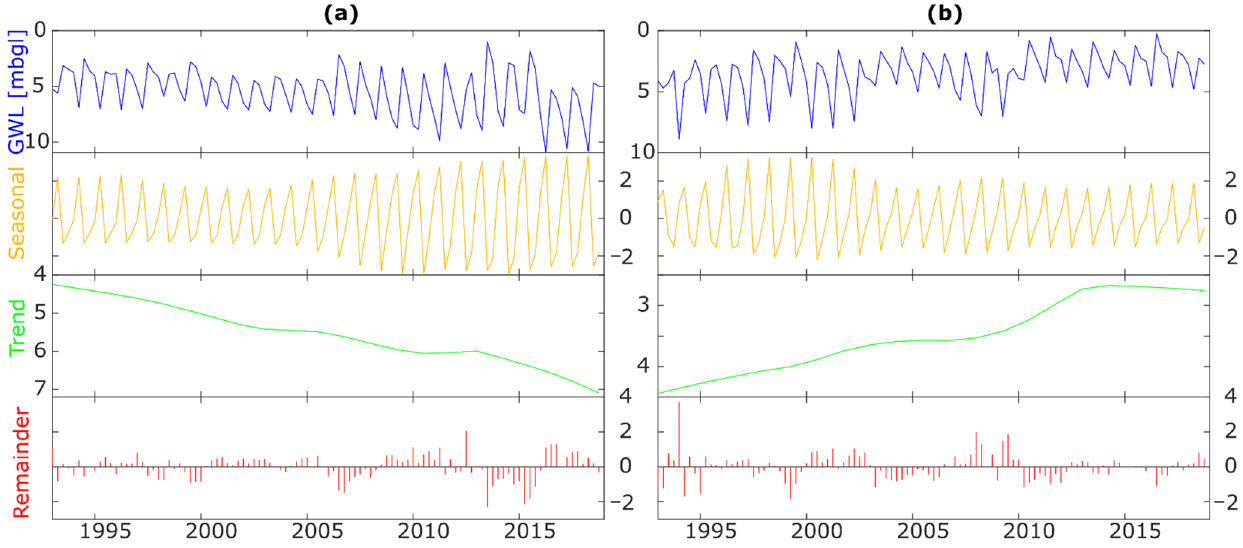
Figure 6. STL decomposition of GWL (1993–2018) and their associated seasonal, trend, and remainder components are shown top to bottom, respectively. ( a ) Shows the STL decomposition of well number BPL-080. ( b ) Shows the STL decomposition of well number SGR019. Both of these wells are located in the Deccan basalt aquifer with phreatic hydrological conditions.